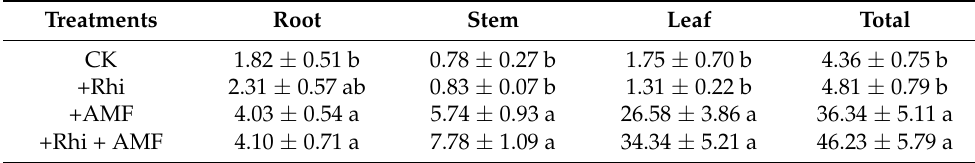
Table 4. Amount of nitrogen transfer in various parts of